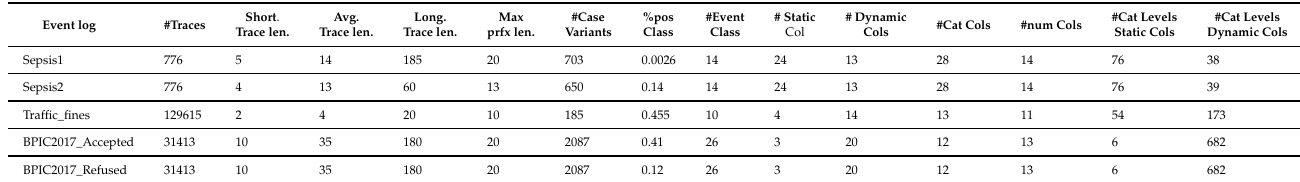
Table 4. Event logs